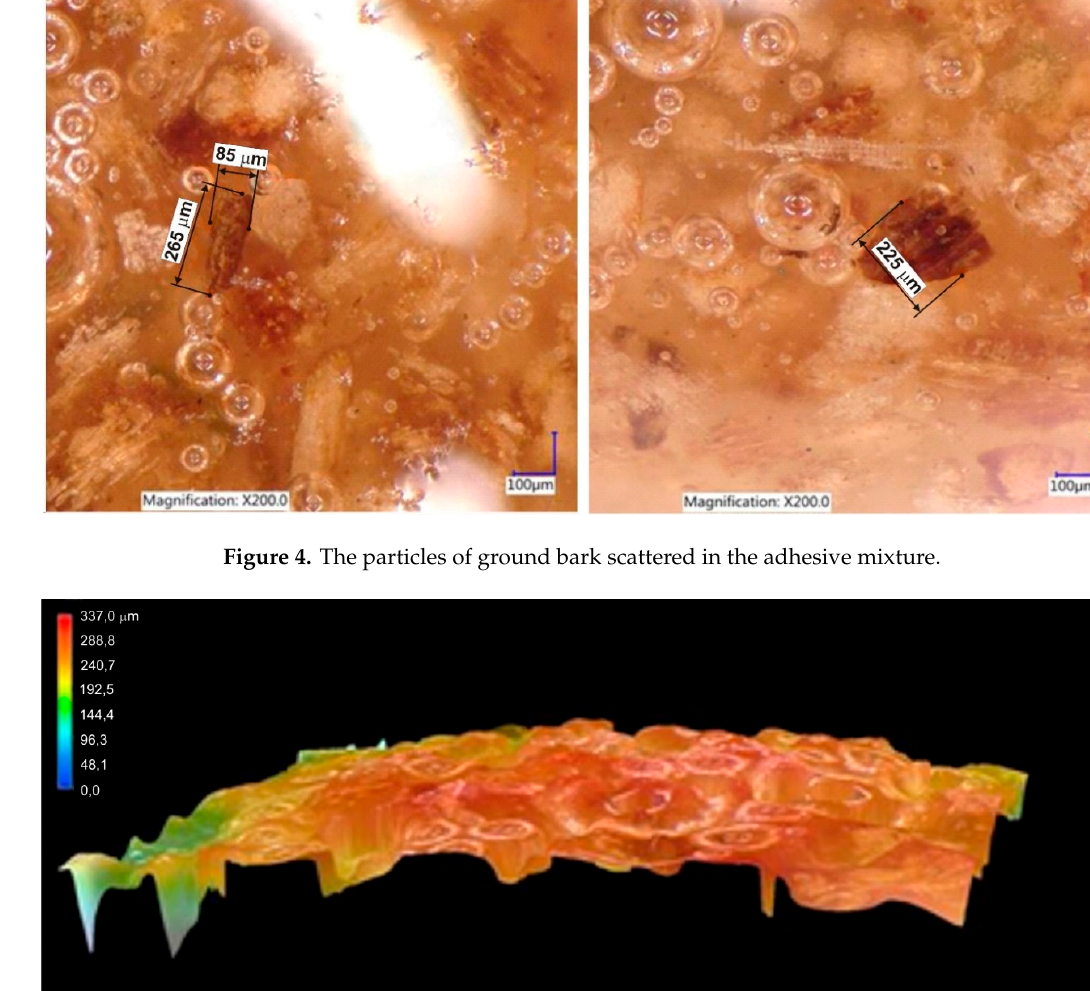
Figure 4. The particles of ground bark scattered in the adhesive mixture.